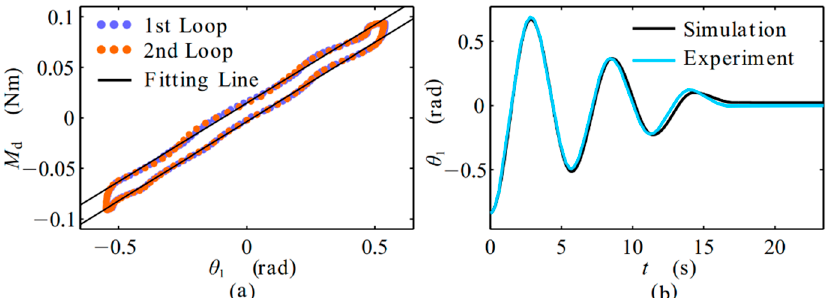
Figure 7. Parameter identification results with spring 2 active: ( a ) excited quasi-static low-frequency oscillation; ( b ) free oscillation after initial displacement.